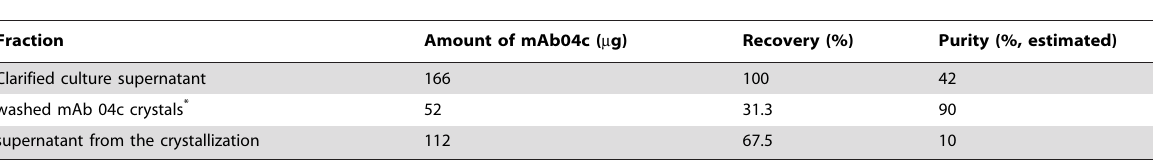
Table 1. Purity and Recovery of crystallized mAb04c.